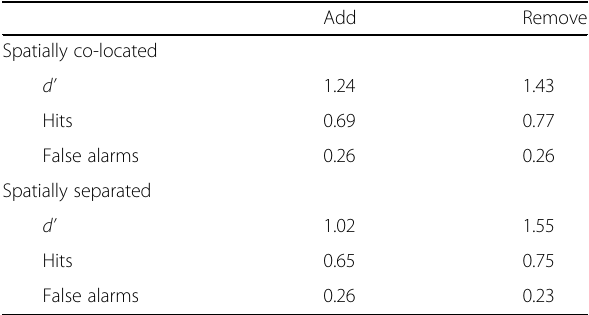
Table 3 Sensitivity ( d ’ ), hits, and false alarms for the cued recall question. Values of d ’ were calculated using a yes/no model (Macmillan & Creelman, 2005)